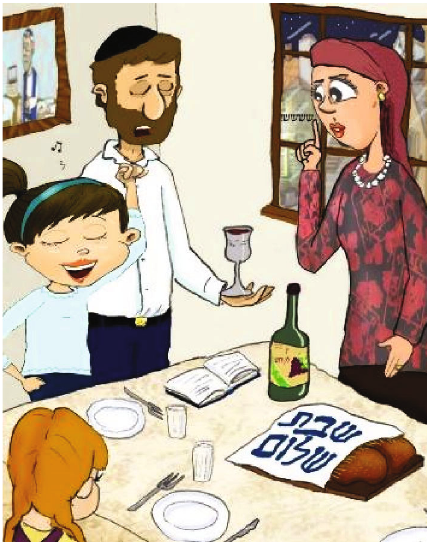
Figure 3: “ Dina fi nds it hard to remain silent during the Shabbat Kiddush. ”